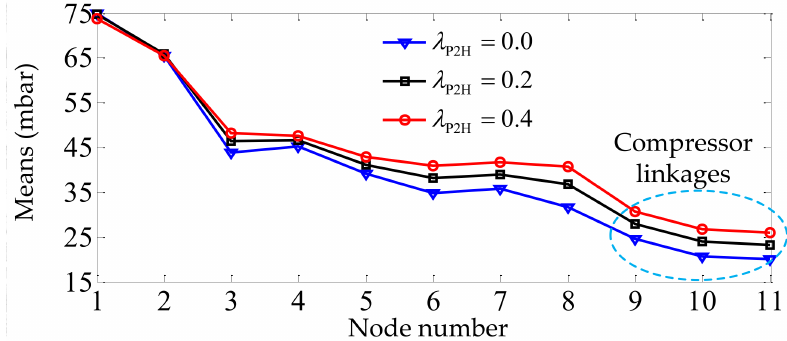
Figure 16. Mean values of the nodal pressures.